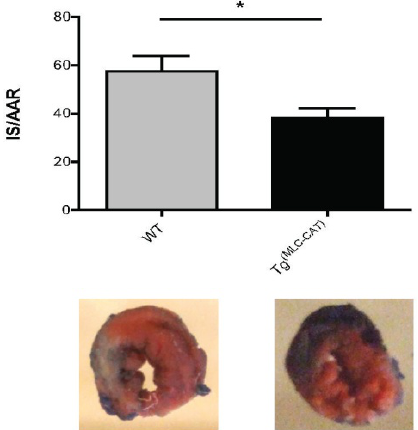
Figure 5. Decrease in infarct size in Tg (MLC − CAT) mice. At day 3 following myocardial infarction, a significant decrease in infarct size was observed in Tg (MLC − CAT) mice as compared to WT mice. Values are mean ± SEM expressed as infarct size/area at risk; n = 5–6 per group; * p < 0.05 t -test.